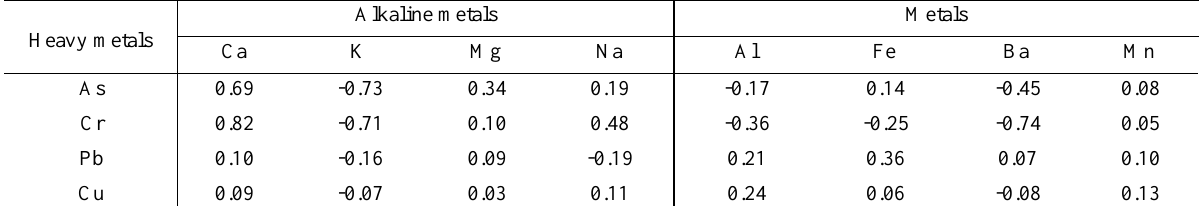
Table 4 . Correlation of soil heavy metals and